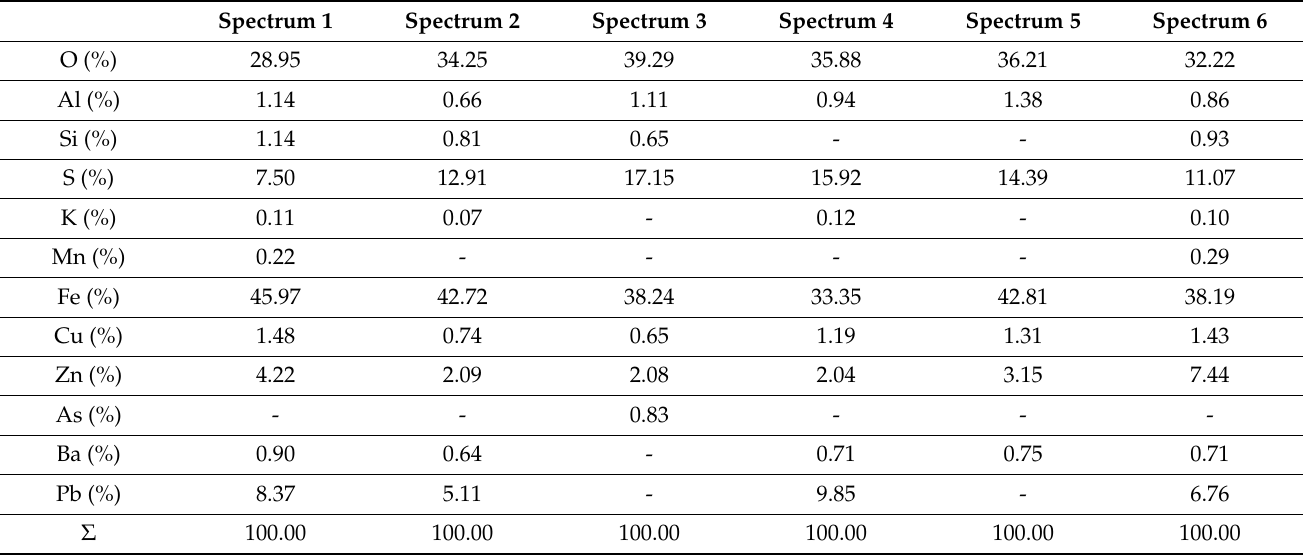
Table 1. EDS analysis of jarosite sample recorded at 1000 × magnification (Figures 4 and 5).